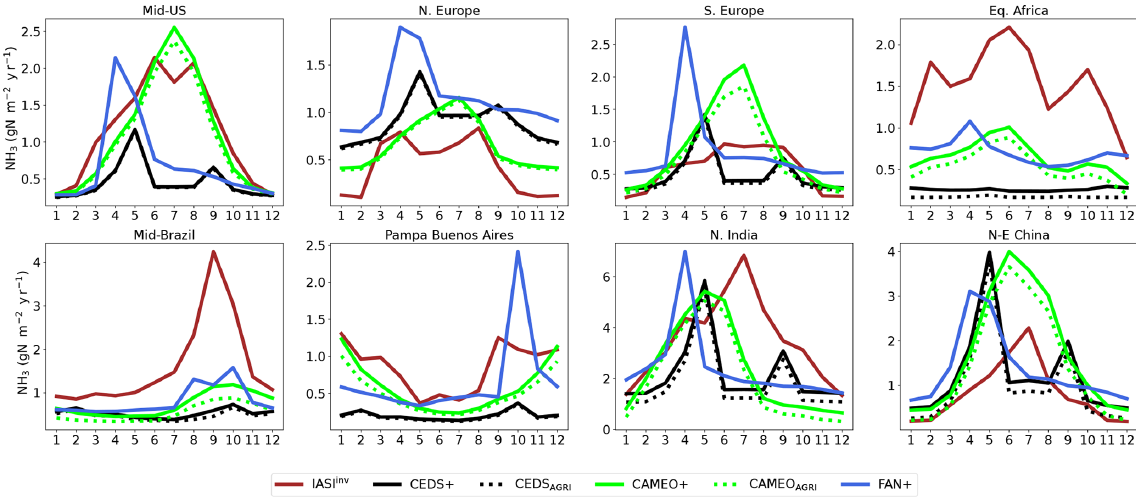
Figure 12. Monthly regional NH 3 emissions (gNm − 2 yr − 1 ). The CAMEO emissions accounting for natural and agricultural emissions aggregated with other sources are represented by the solid green line (CAMEO + ), and CAMEO emissions accounting for agricultural emissions are shown using the dotted green line (CAMEO agri ). The agricultural sector of CEDS alone and CEDS aggregated with other sources are represented by black dotted (CEDS agri ) and solid lines (CEDS + ), respectively. The IASI inv product is shown in red (IASI inv ). The agricultural emissions from FANv2 aggregated with other sources are shown in blue (FAN + ). Other sources include biomass burning from van der Werf et al. (2010) and industrial and waste sectors from CEDS. The regions are defined in Fig.